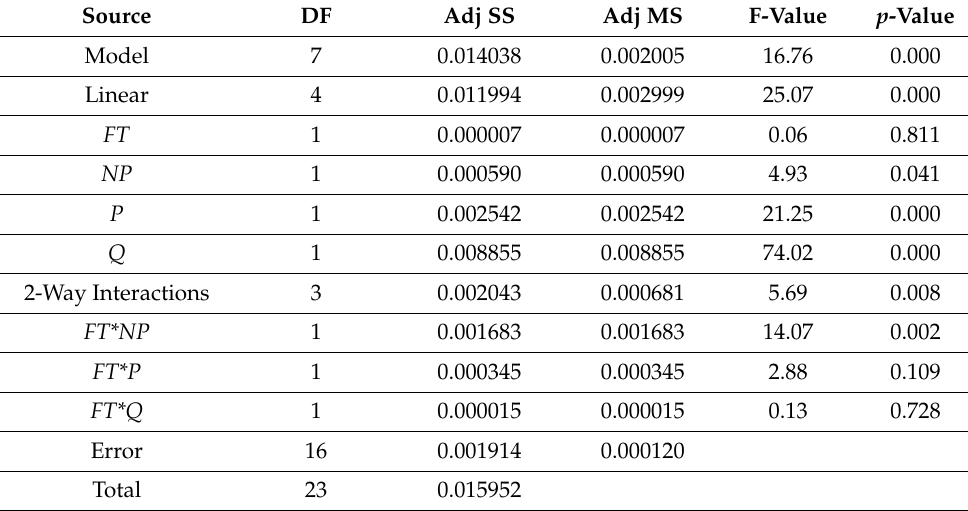
Table 3. Results of ANOVA analysis of surface roughness R a .